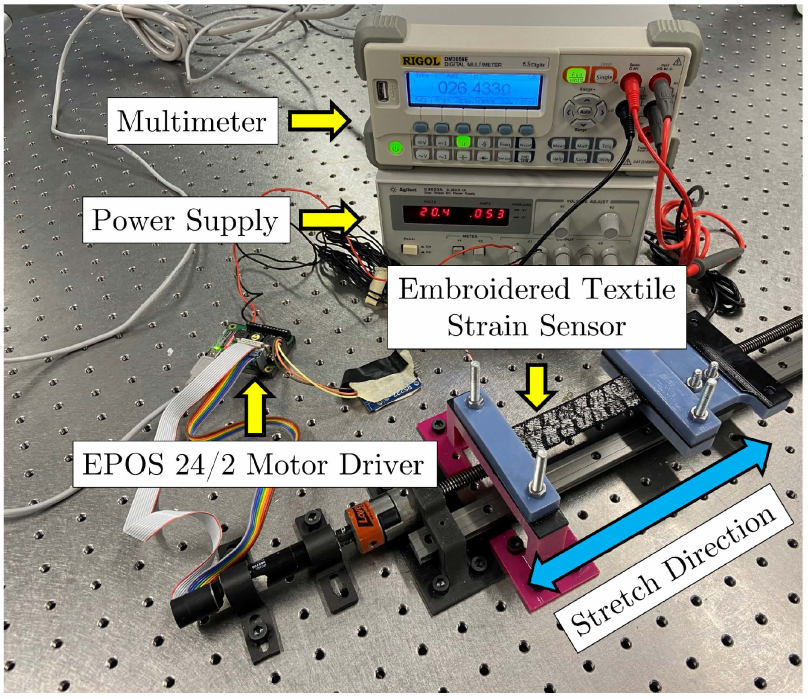
Figure 8. Testing setup used for collecting data from the embroidered textile strain